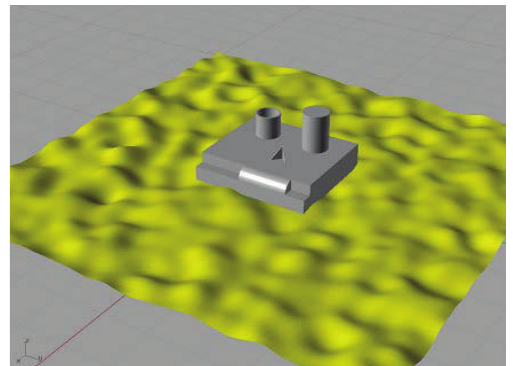
F 2: e geometrical model of a SLICY-like target above a Gaussian rough